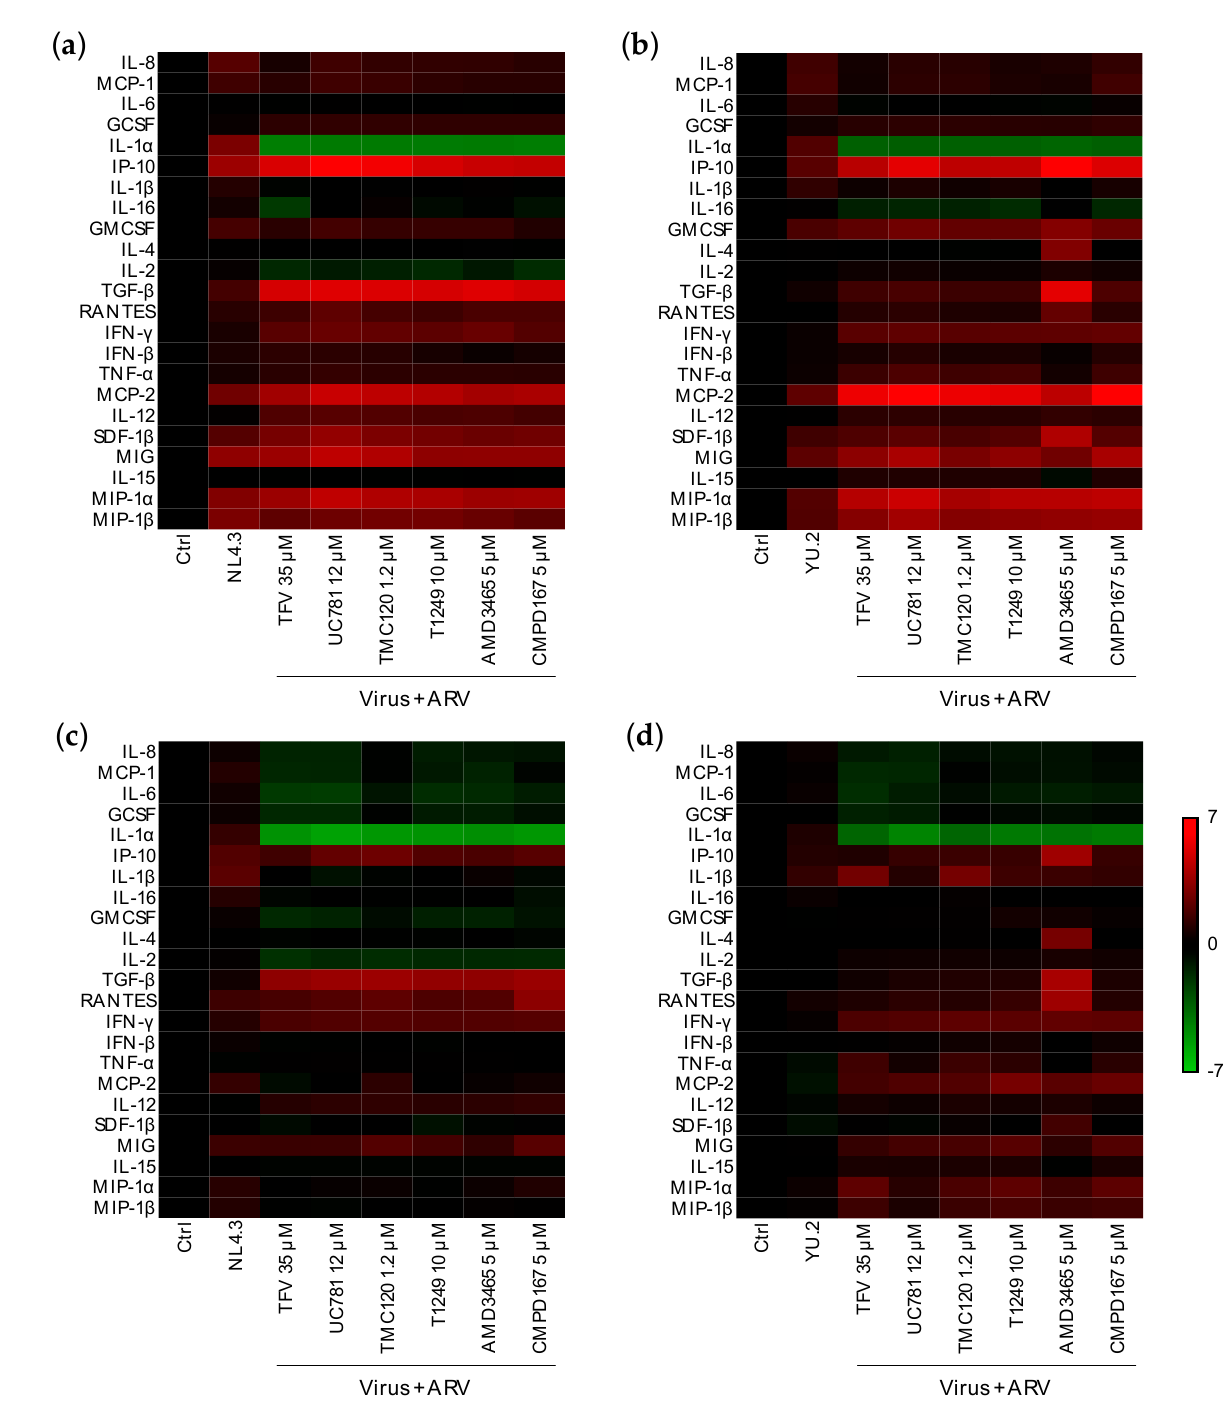
Figure 5. Effect of ARVs on the mucosal cytokine profile induced post-viral challenge of colorectal explants. Heatmap representing cytokines that are upregulated (red) or downregulated (green) ( a , b ) 6 or ( c , d ) 24 h after challenge in the presence or absence of ARV in comparison to untreated explants. Differences are shown in Log2 from two independent experiments performed in quadruplicate.